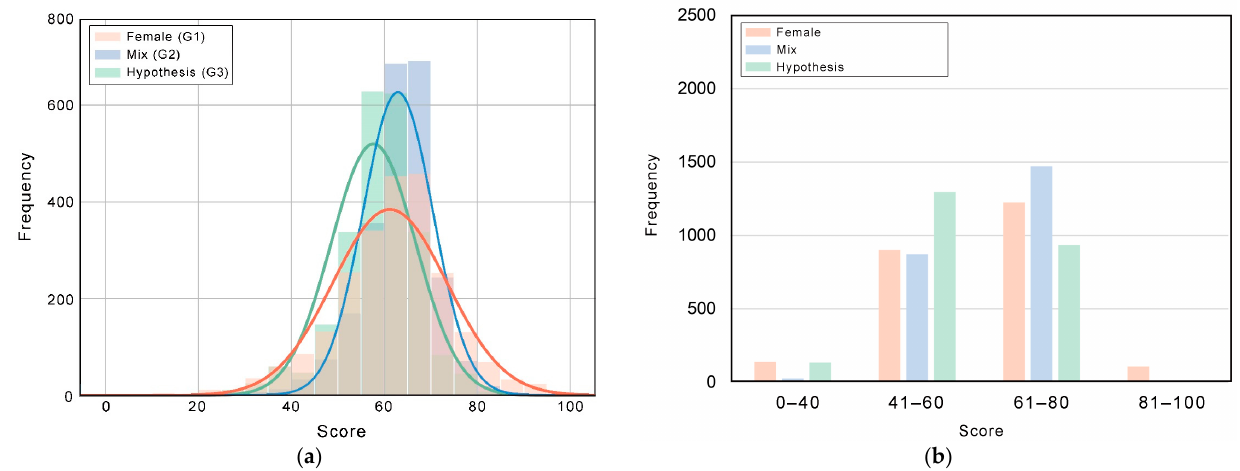
Figure 7. Volunteer scoring results: ( a ) histogram; ( b ) histogram of segment scores.